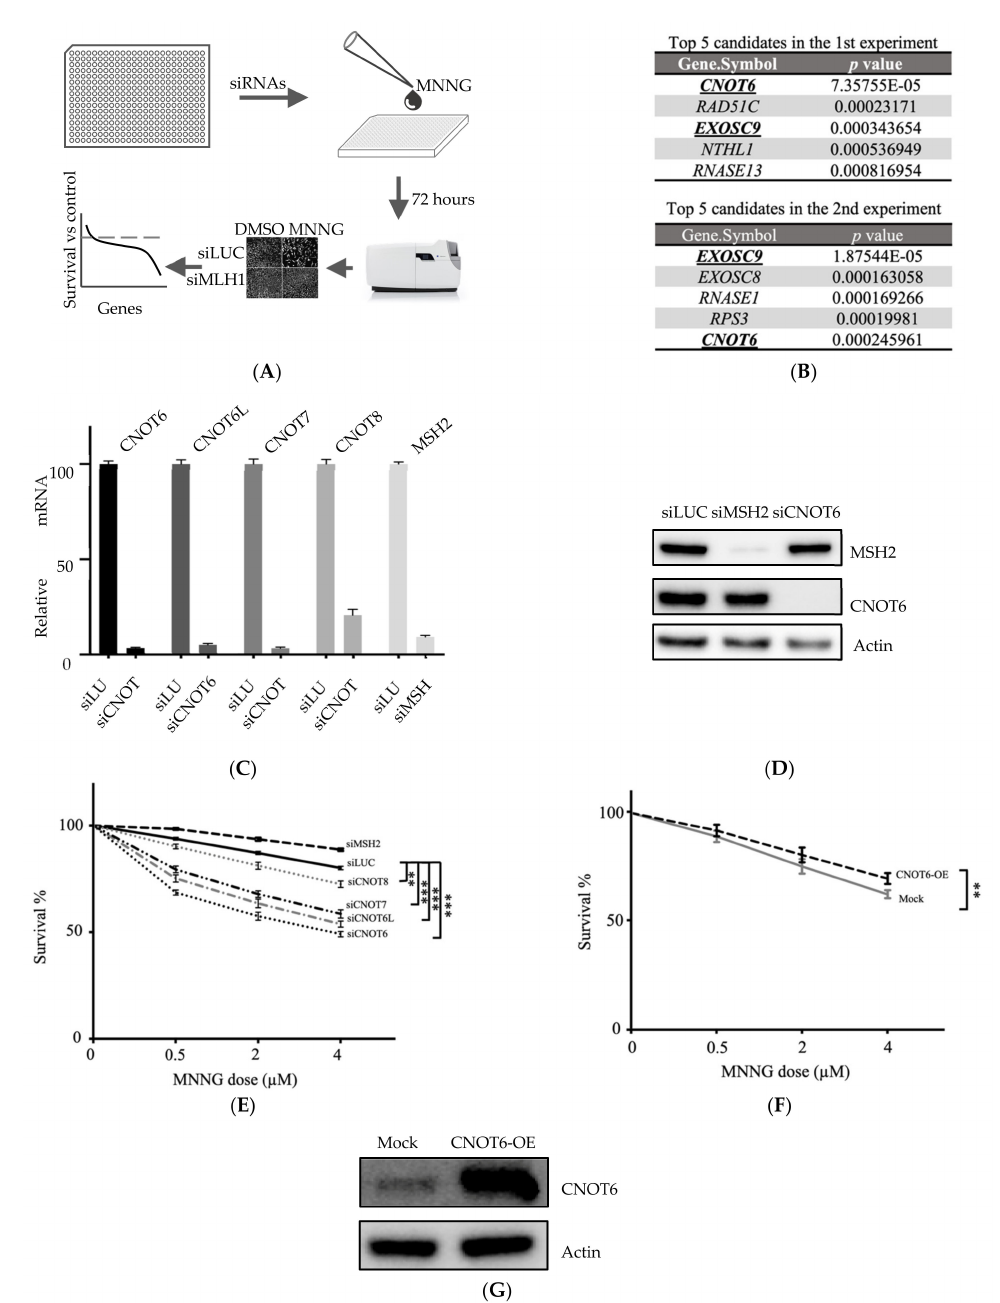
Figure 1. siRNA-based high-throughput screen identifies CNOT6 as a potential MMR regulator. ( A ) Schematic depiction of the screening procedure combining custom made siRNA libraries of 160 human nucleases, MNNG treatment. The screening endpoint was cell survival. ( B ) The top five candidates from two independent experiments are shown. ( C ) SiRNA-mediated knockdown efficiency was quantified for the indicated genes by real-time quantitative PCR. GAPDH was the reference gene ( n = 3). ( D ) Representative immunoblots of MSH2, CNOT6 and Actin in extracts of U2OS cells treated with siRNA targeting CNOT6 or MSH2. ( E ) The viability of siRNA- transfected cells treated with MNNG at the indicated dose is shown. Data are shown as mean ± SEM, n = 3. Statistical significance (** p < 0.01, *** p < 0.001) was determined using an unpaired two-tailed survival is shown for cells overexpressing CNOT6 or control cells. Data are shown as mean ±